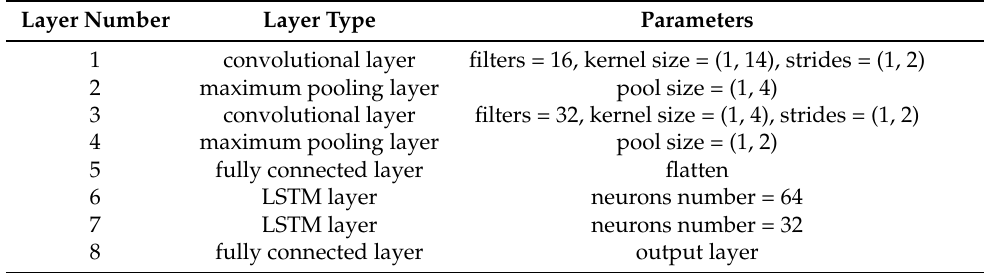
Table 1. Network structure and parameters Settings of CNN-LSTM. Layer Number Layer